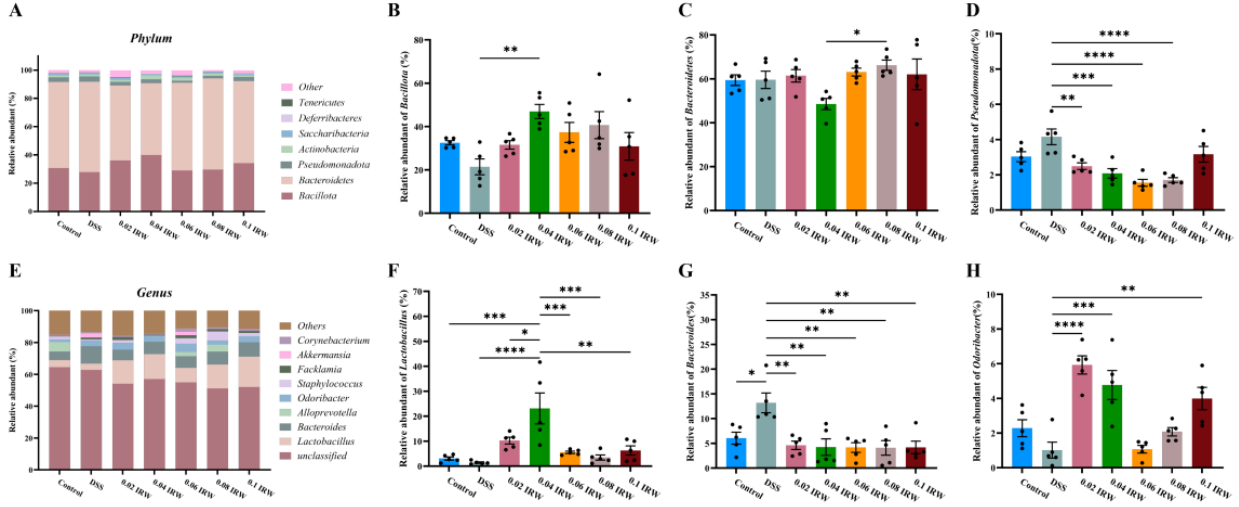
Figure 4. Microbial composition of the mouse colon: ( A ) microbial composition at the phylum level, ( B ) relative abundance of Bacillota, ( C ) relative abundance of Bacteroidota, ( D ) relative abundance of Pseudomonadota, ( E ) microbial composition at the genus level, ( F ) relative abundance of Lactobacillus , ( G ) relative abundance of Bacteroides , ( H ) relative abundance of Odoribacter ( n = 5); * indicates p < 0.05; ** indicates p < 0.01; *** indicates p < 0.001; **** indicates p < 0.0001.